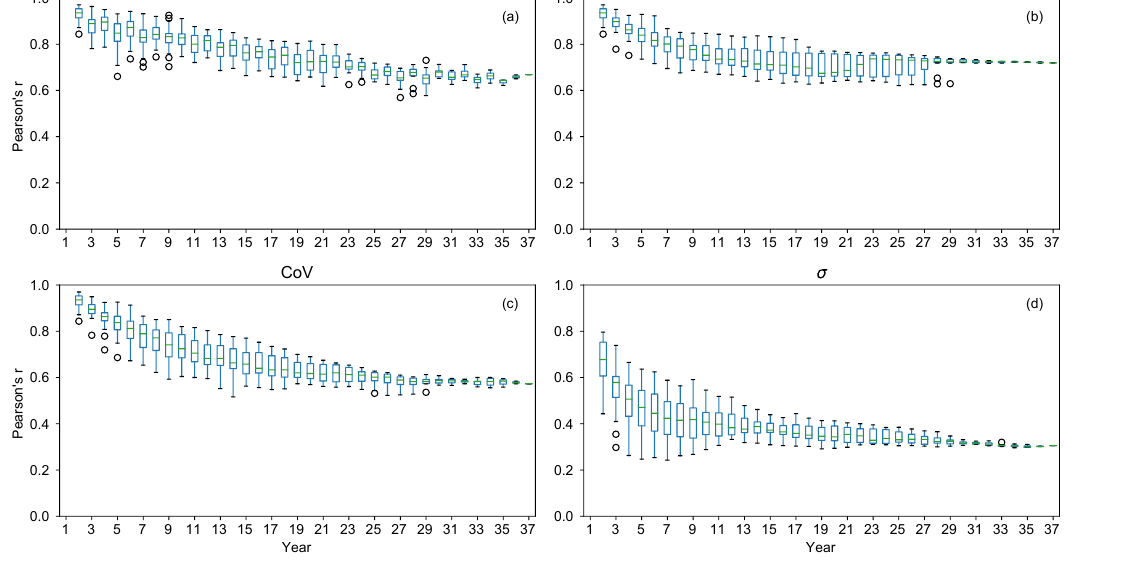
Figure 7. As in Fig. 5, but for annual-mean data.